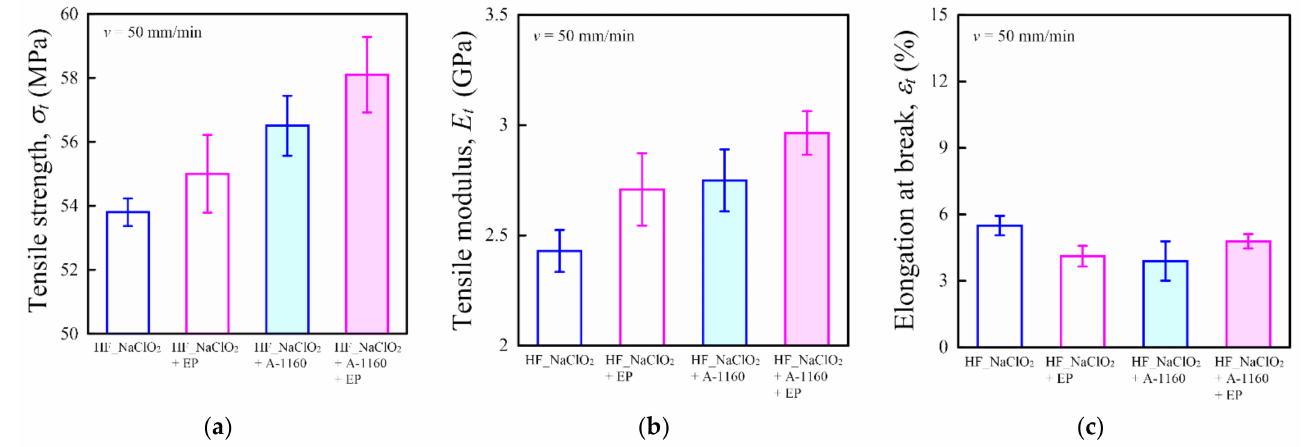
Figure 5. Tensile properties of various surface-treated HF/PA1010 biomass composites: ( a ) tensile strength σ t , ( b ) tensile modulus E t , and ( c ) elongation at break ε t